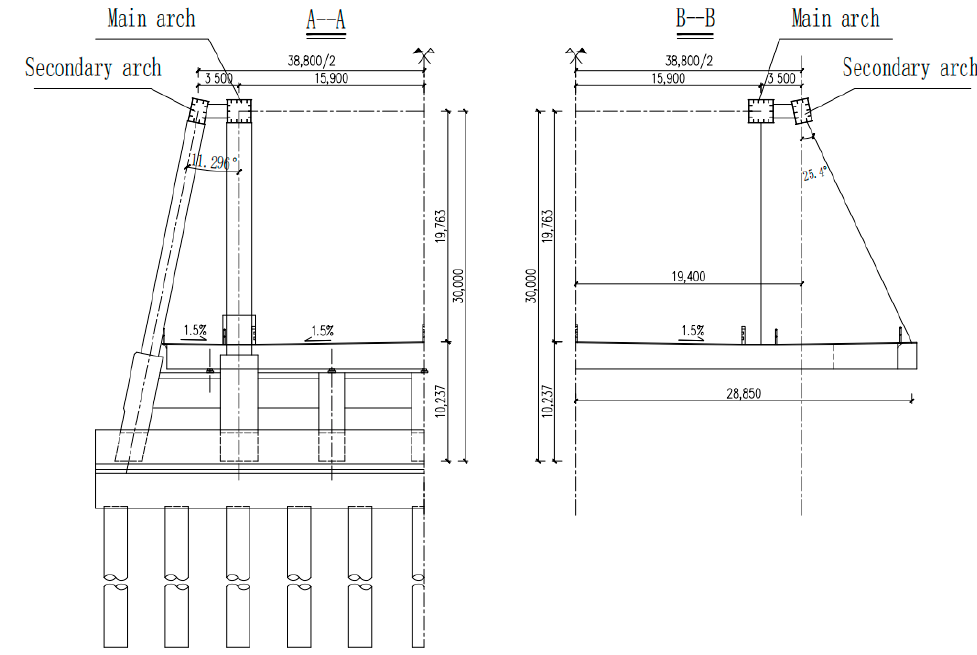
Figure 2. Bridge-type diagram of the bridge (unit: mm).